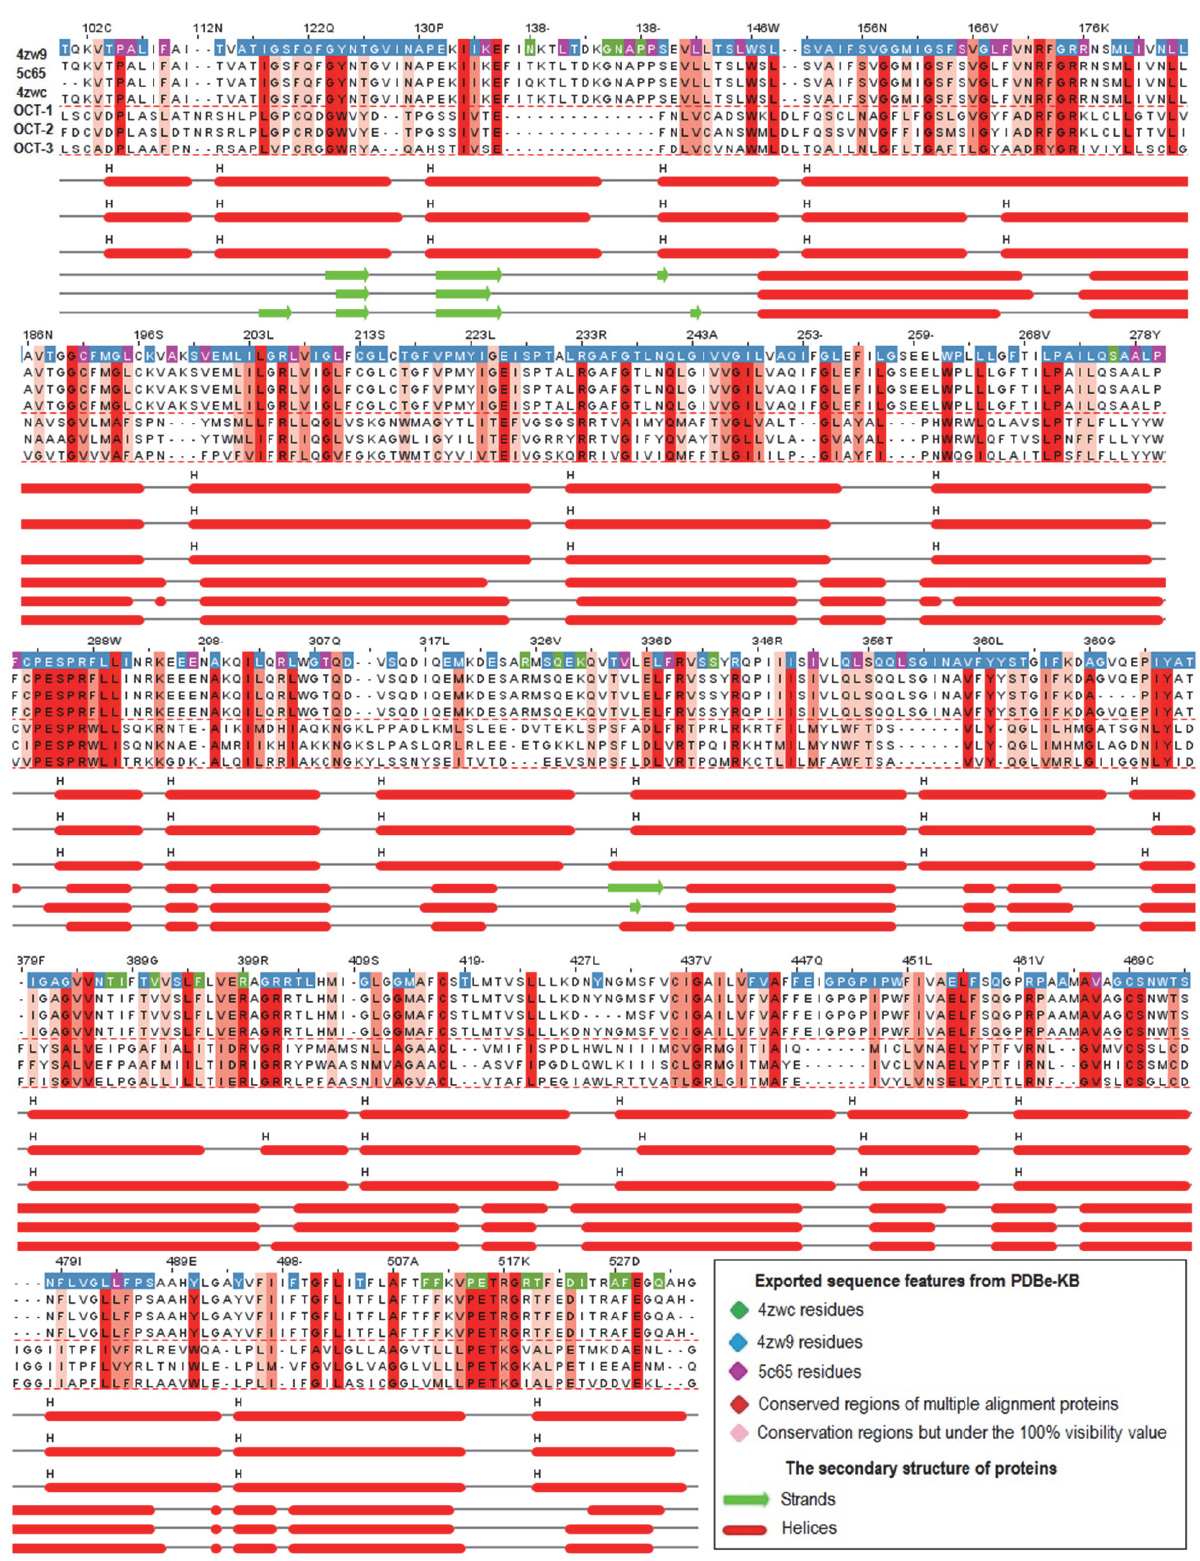
Figure 2. The representation of primary and secondary structure of 4zw9, 5c65, and 4zwc, and OCT1-3 proteins. The visualization of sequence features and the Conserved Domain of the protein residues are colored through an analysis performed by the Jalview 2.11.0. The probability of con- served regions decreases through the dark red to the pink. After the multiple alignments, the OCT-1 protein was set as the reference for the sequence numbering. As a result of multiple sequencing, the overlapping regions of the proteins were solely